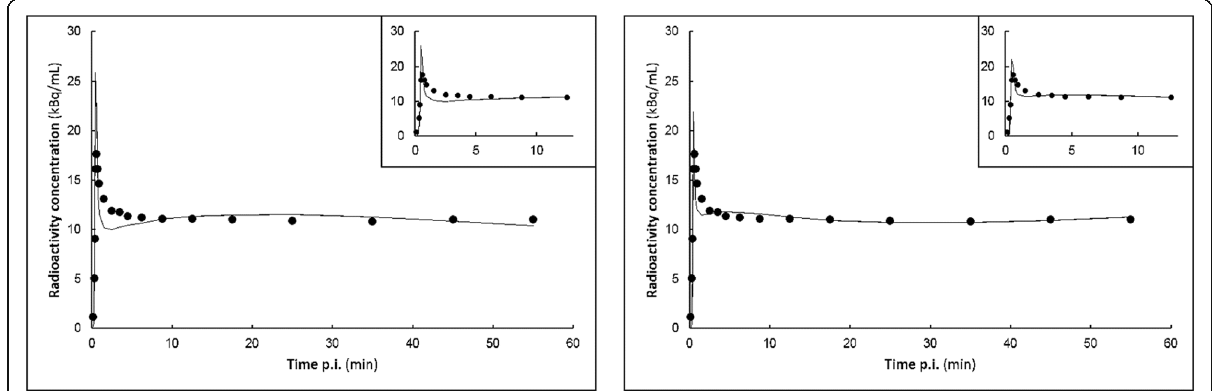
Fig 2 Fits of the tumour TAC of patient 7. Circles represent input data and curves model fits. Details of the fits of the peaks are shown as insets.